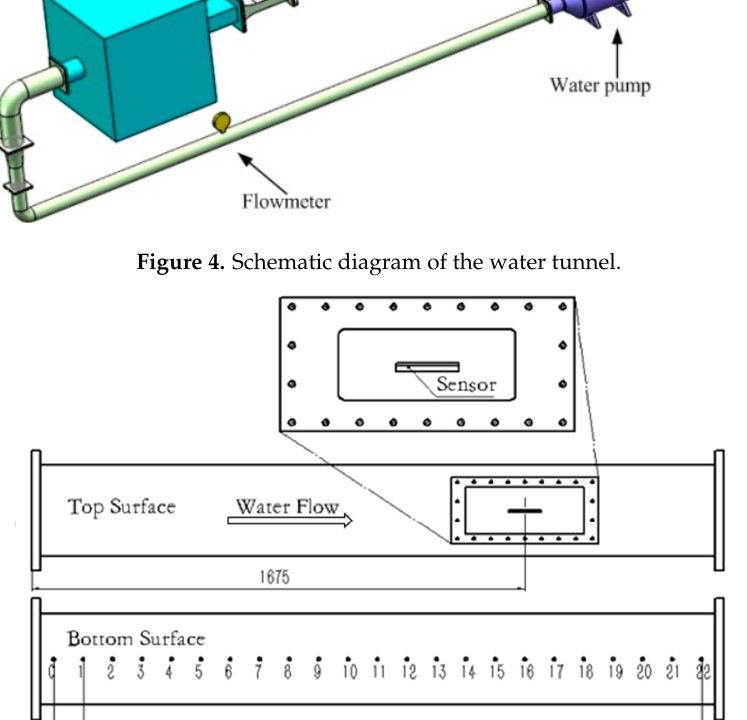
Figure 5. Schematic drawing of the test section.